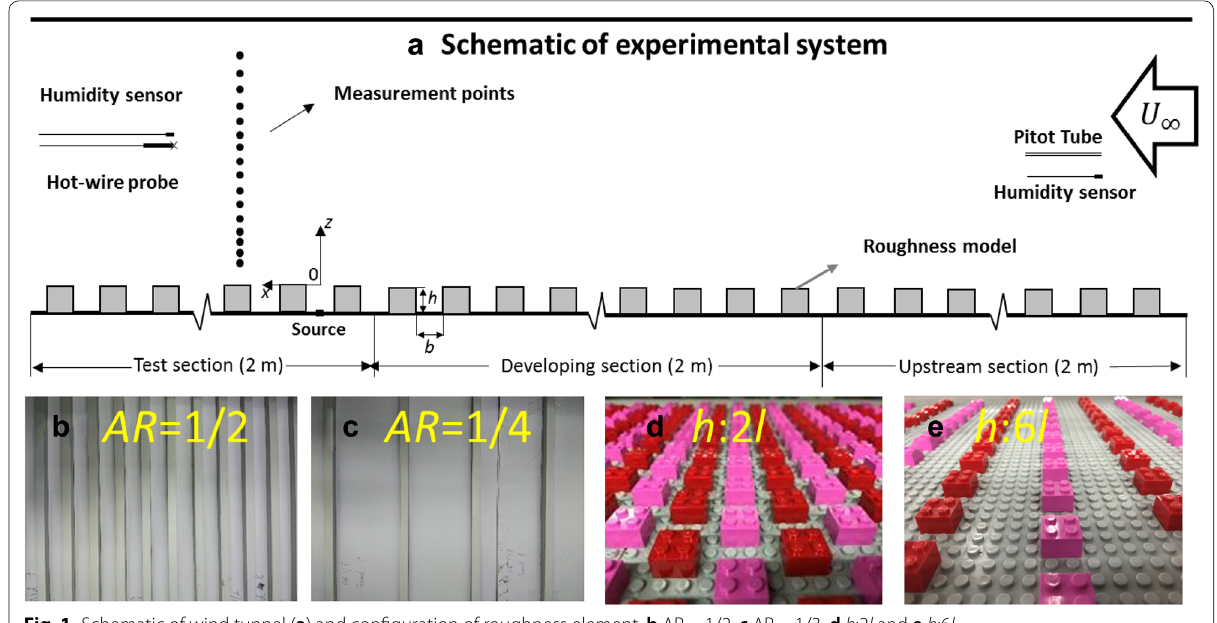
Fig. 1 Schematic of wind tunnel ( a ) and configuration of roughness element. b AR